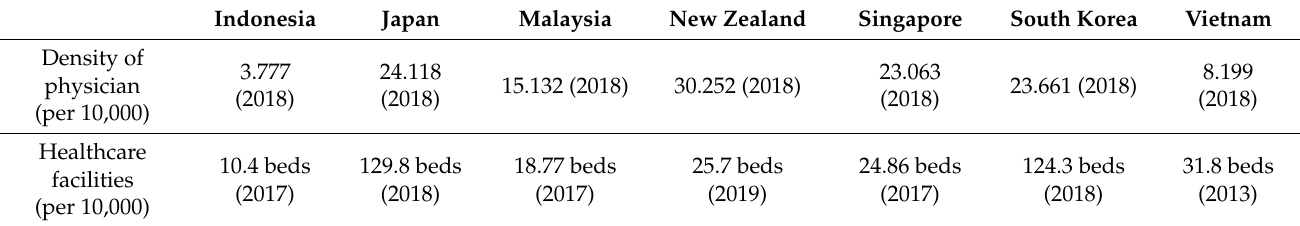
Table 8. Components that affect the adequacy of facilities.